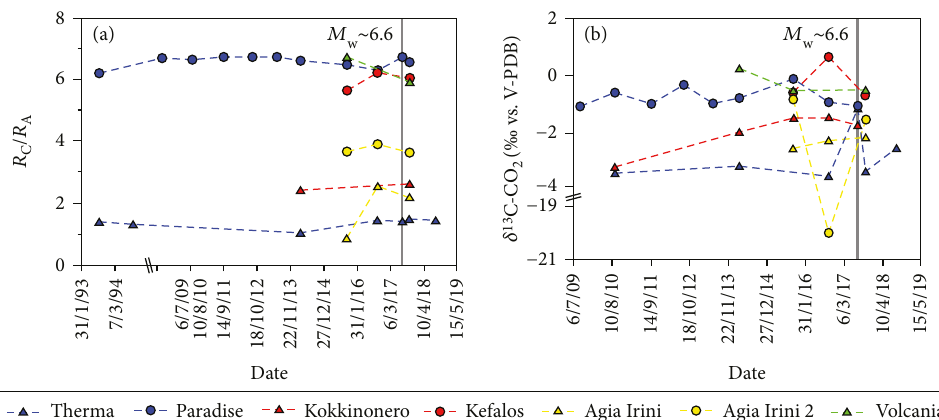
Figure 8: Time series plot of (a) R variable of the atmospheric contamination, the R